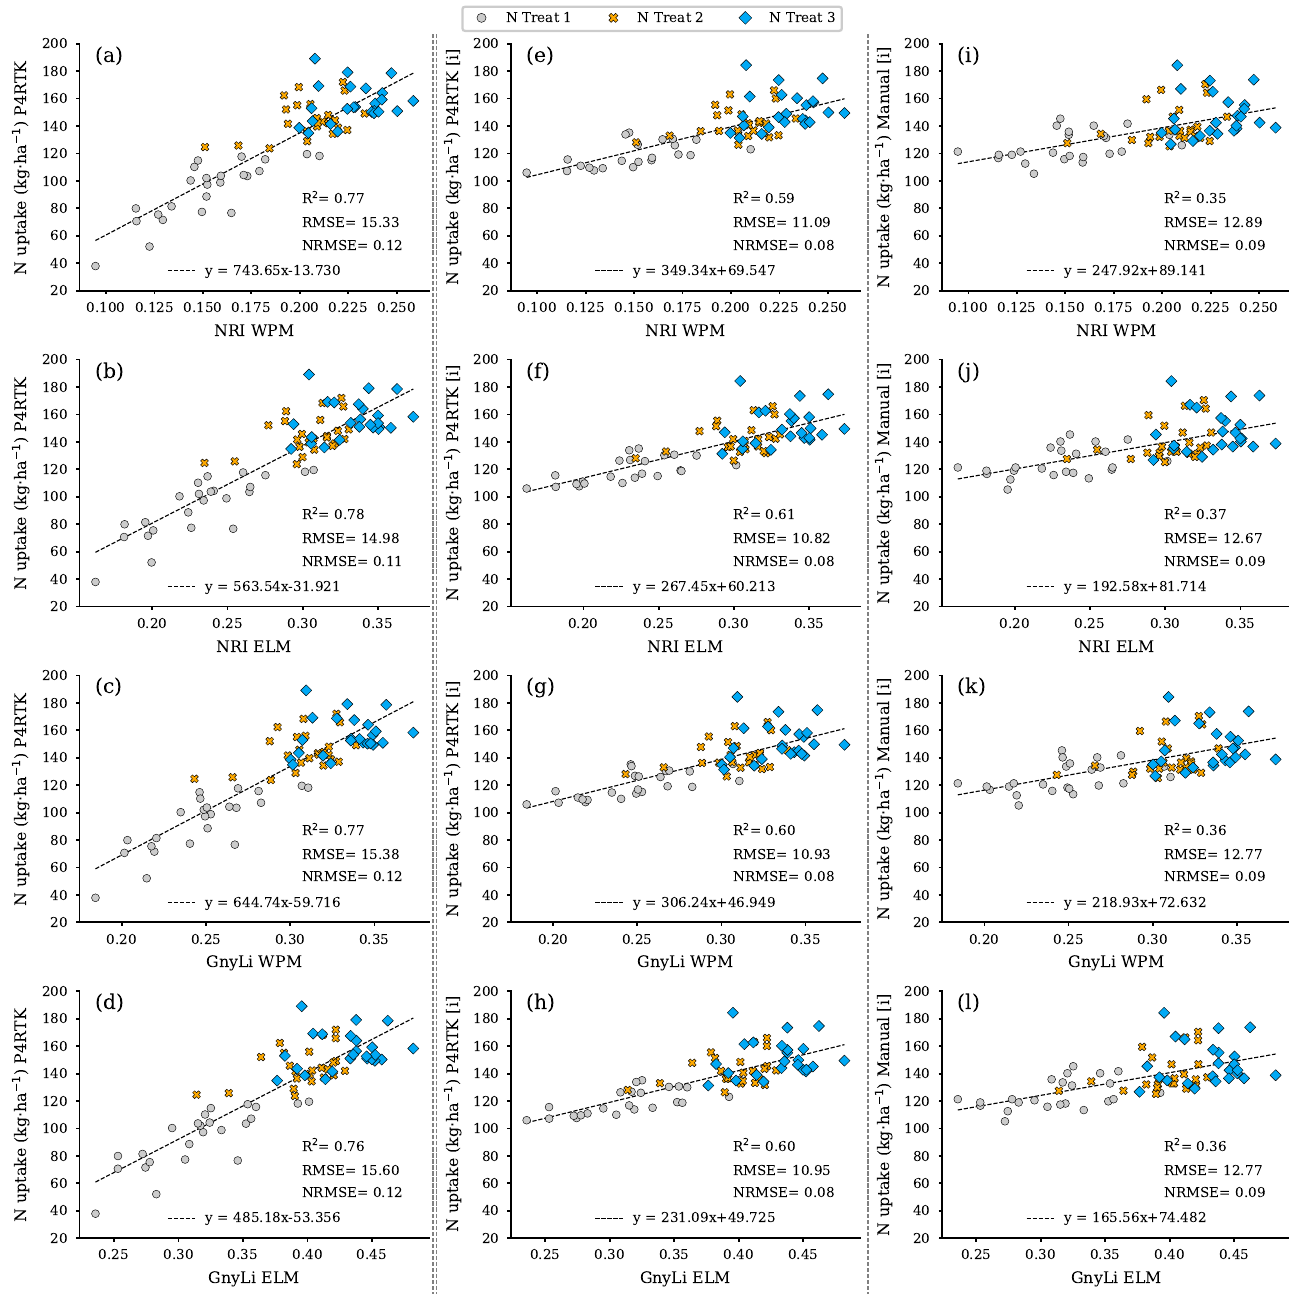
Figure 18. Scatter plots for the N uptake data estimated for the 72 non-destructive test plots with the N C and DBM RM-model, based on the DBM estimator RM for three different CH data sets, with the spectral camera VIs acquired on 2 June. Left column: CH directly derived for 2 June P4RTK RGB data set ( a – d ). Center column: linear interpolated CH from 26 May and 12 June P4RTK RGB data sets ( e – h ). Right column: linear interpolated CH manually measured on 26 May and 9 June ( i – l ). ( p < 0.001 for all regression